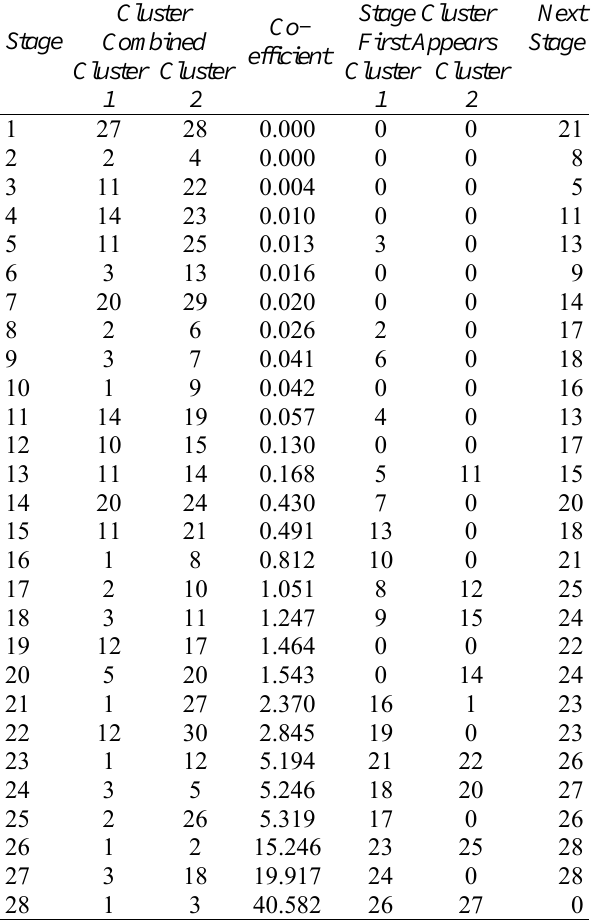
Table 9: Hierarchical cluster analysis: agglomeration schedule.